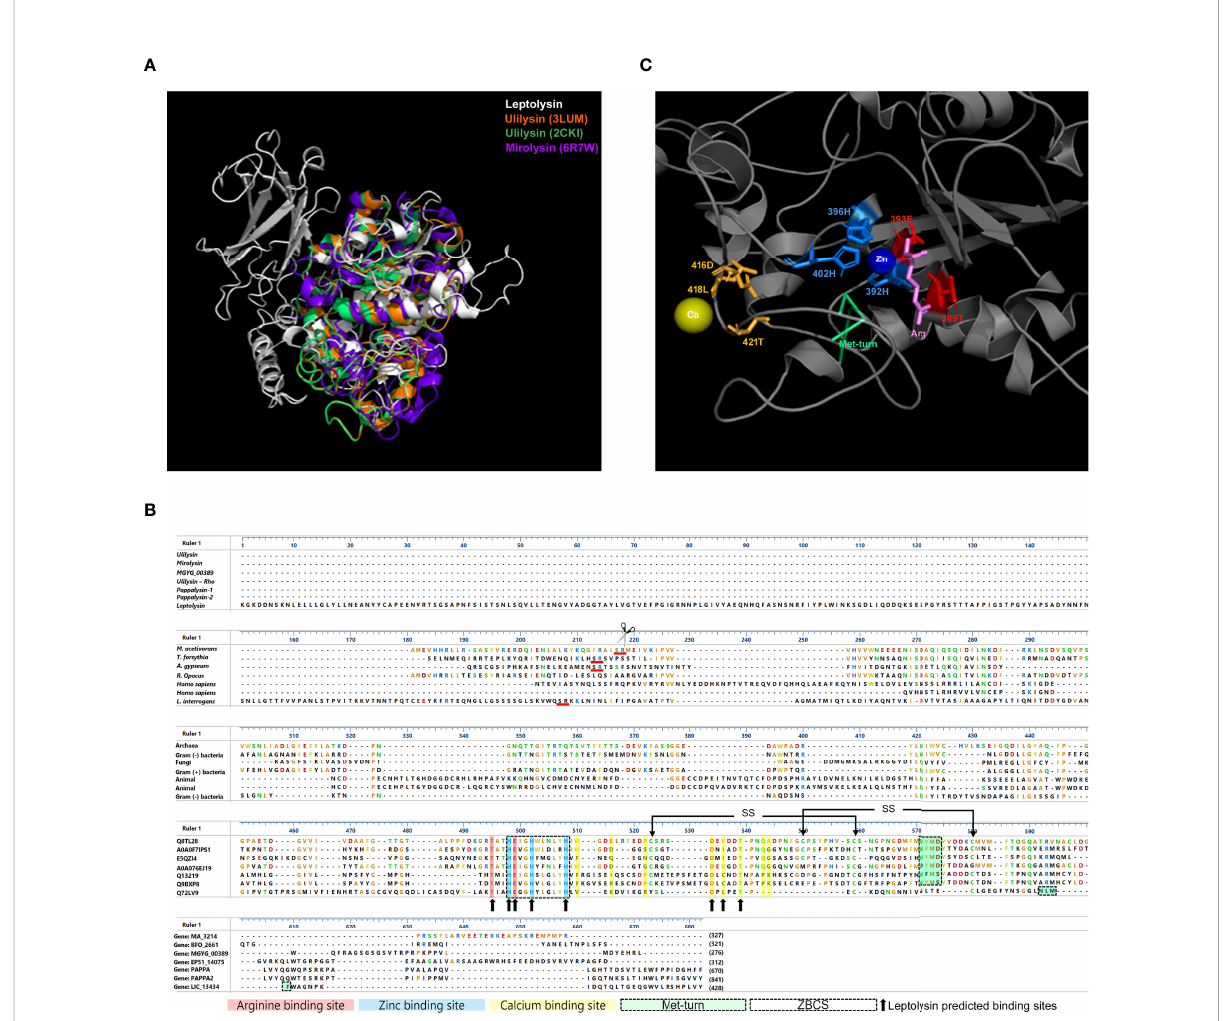
FIGURE 1 Comparative analysis of short pappalysins. (A) 3D structure of leptolysin structurally aligned to ulilysin 3LUM (orange) and 2CKI (green) and mirolysin (purple); (B) M43 metalloproteases alignment: L. interrogans leptolysin, M. acetivorans ulilysin, T. forsythia mirolysin, R. Opacus ulilysin, A. gypseum extracellular metalloprotease MGYG_00389 and H. sapiens pappalysin-1 and pappalysin-2 were aligned by Muscle. The zinc- binding consensus sequence (ZBCS) is boxed. Ulilysin arginine (red), zinc (blue), and calcium (yellow) -binding sites are highlighted, while corresponding leptolysin residues within those binding sites are indicated by black arrows. Met-turn structures are boxed and highlighted in green. Red lines indicate Serine-Argine residues, site of autolytic cleavage of ulilysin and mirolysin. Ulilysin disul fi de bonds (SS) are indicated by arrows above cysteines. (C) L. interrogans leptolysin predicted binding sites: calcium-binding sites are indicated by gold sticks, zinc-binding sites are indicated by blue sticks and arginine binding sites are highlighted in red. The Met-turn is shown in green. Calcium (Ca) and zinc (Zn) ligands are represented by yellow and blue spheres, respectively, while arginine (Arg) is indicated by pink